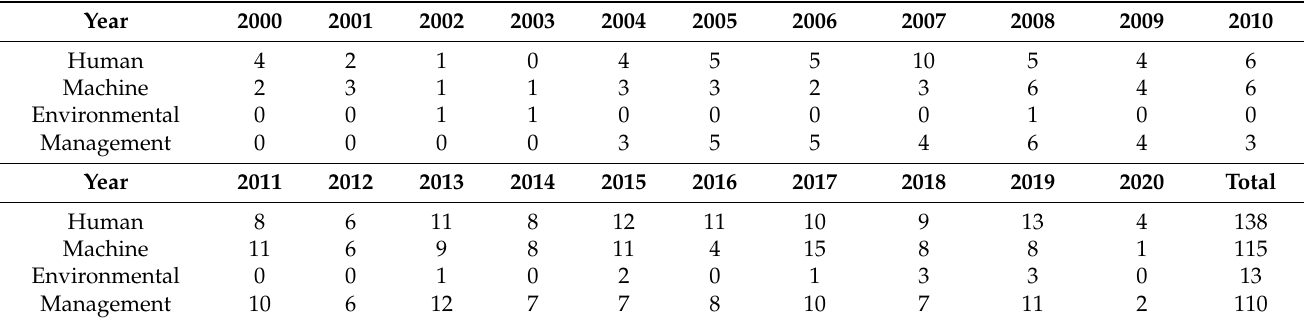
Table 4. Frequency for causes of large and above accidents each year.